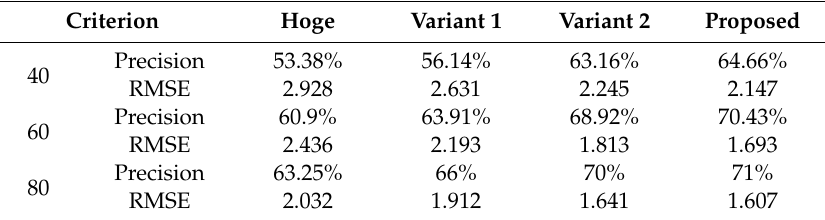
Table 2. Matching performance of the baseline, two variants and the proposed method (root mean square error (RMSE) unit: